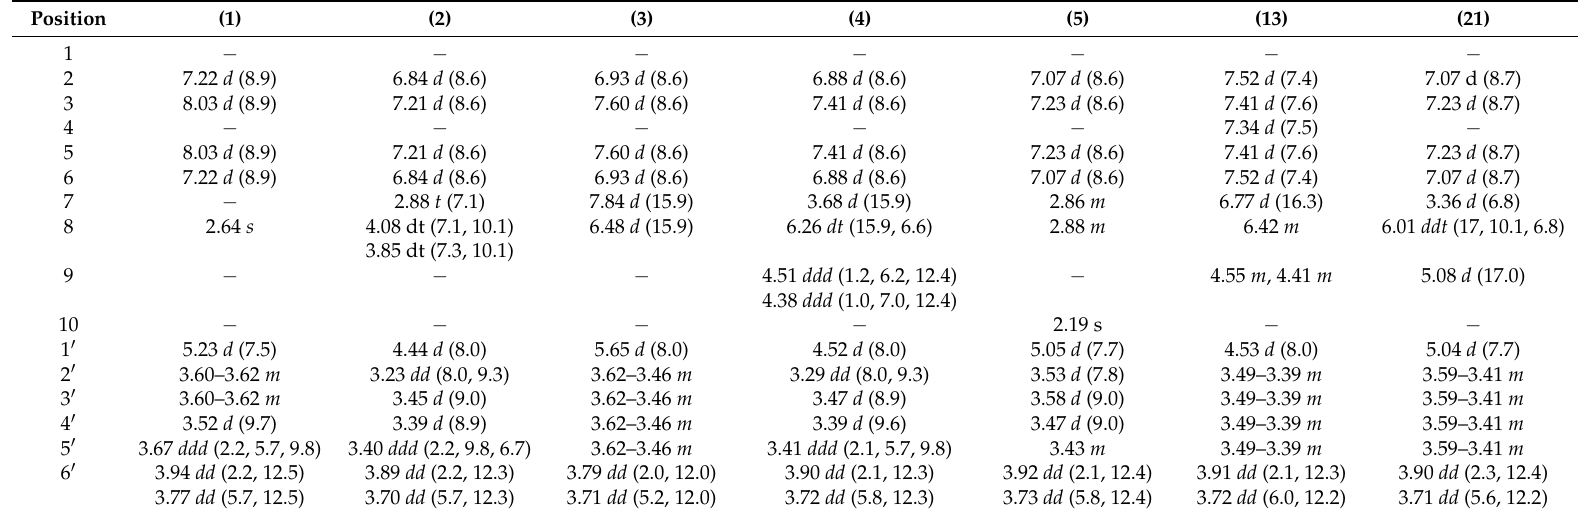
Table 2. 1 H-NMR data of monosaccharides found in S. triandra × dasyclados hybrid (NWC1283) wood chip